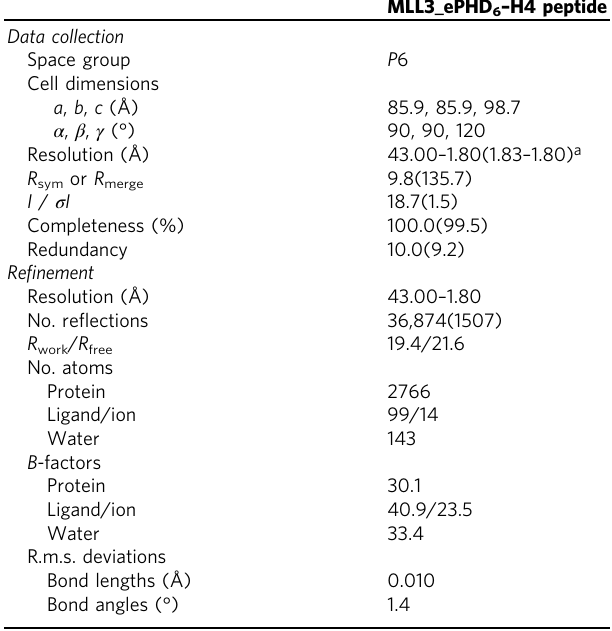
Table 3 Data collection and re fi nement